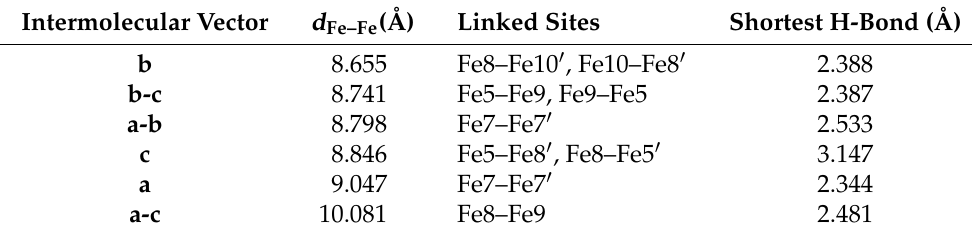
Table 7. The short overall Fe–Fe distances between neighbouring molecules in the lattice and the shortest intermolecular H-bonds not involving lattice